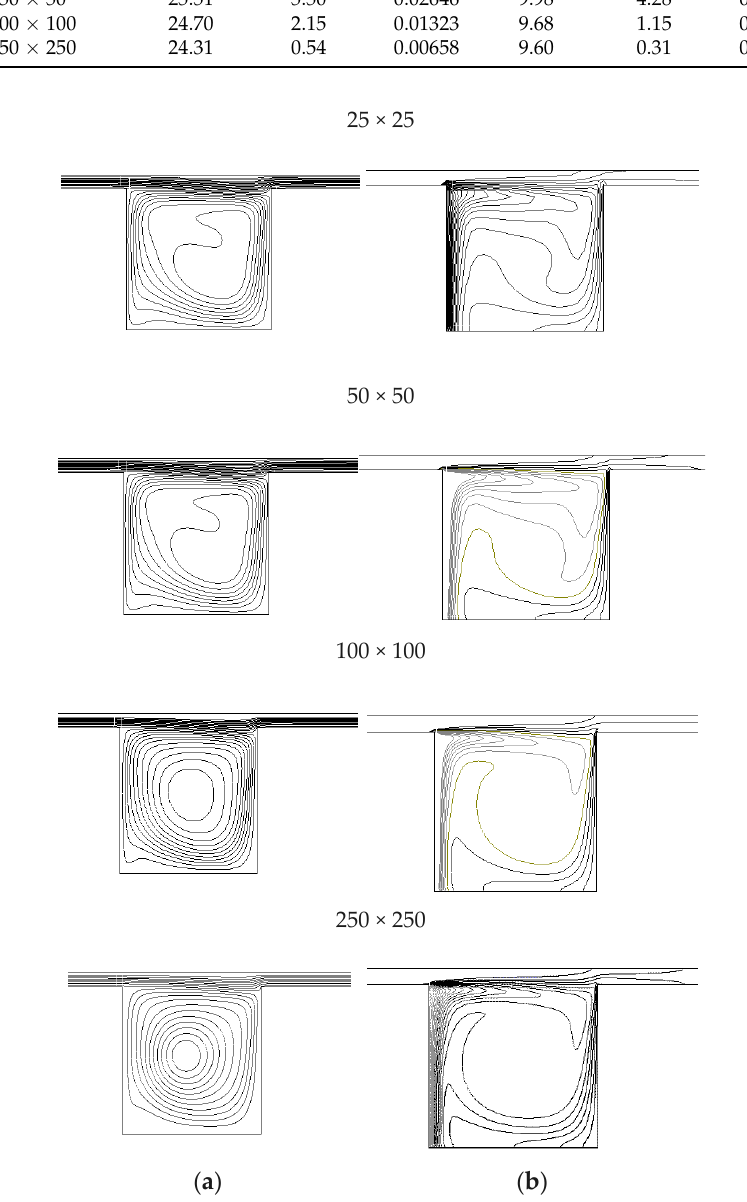
Figure 2. Streamlines ( a ) and isotherms ( b ) for different numbers of nodes.